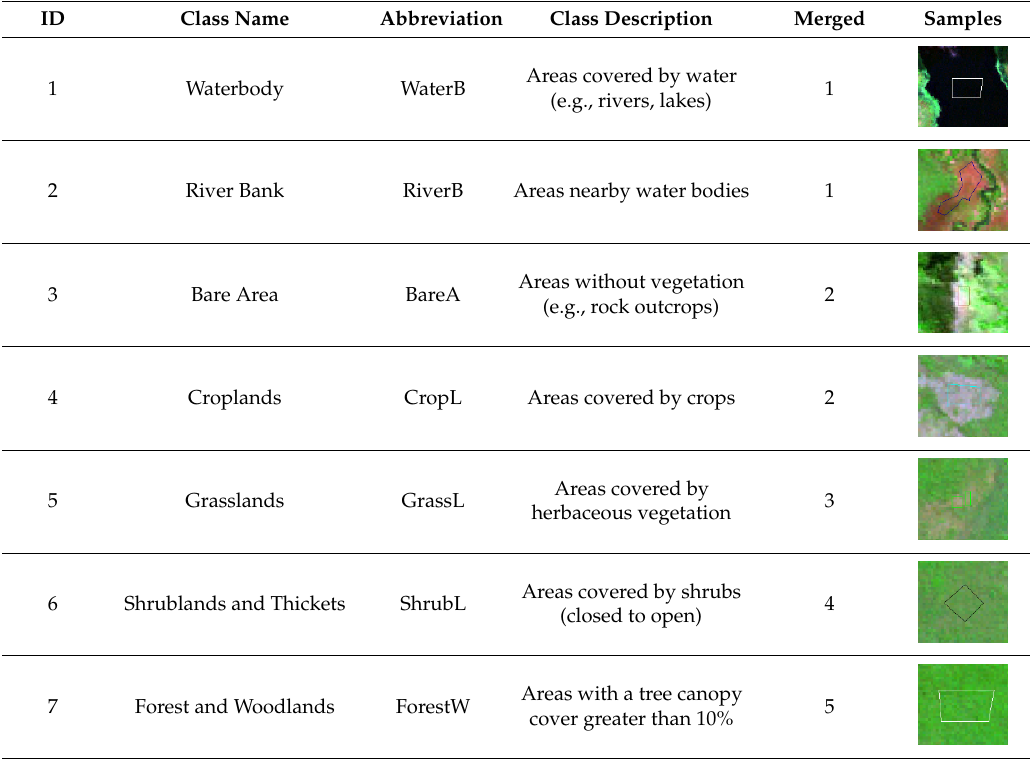
Table 1. Classes used for classification and merged 5-class distribution.